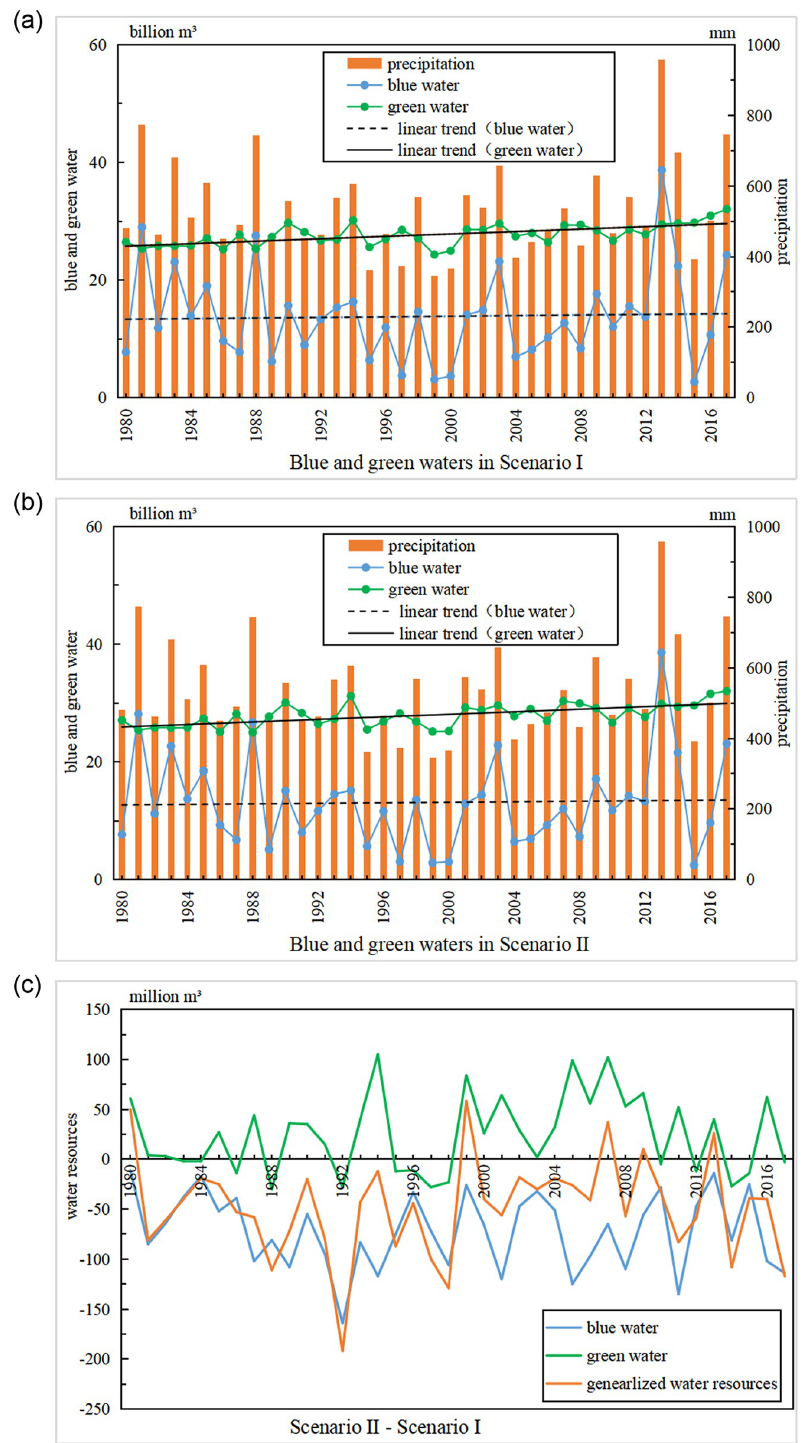
Fig 5. Time series changes of annual water